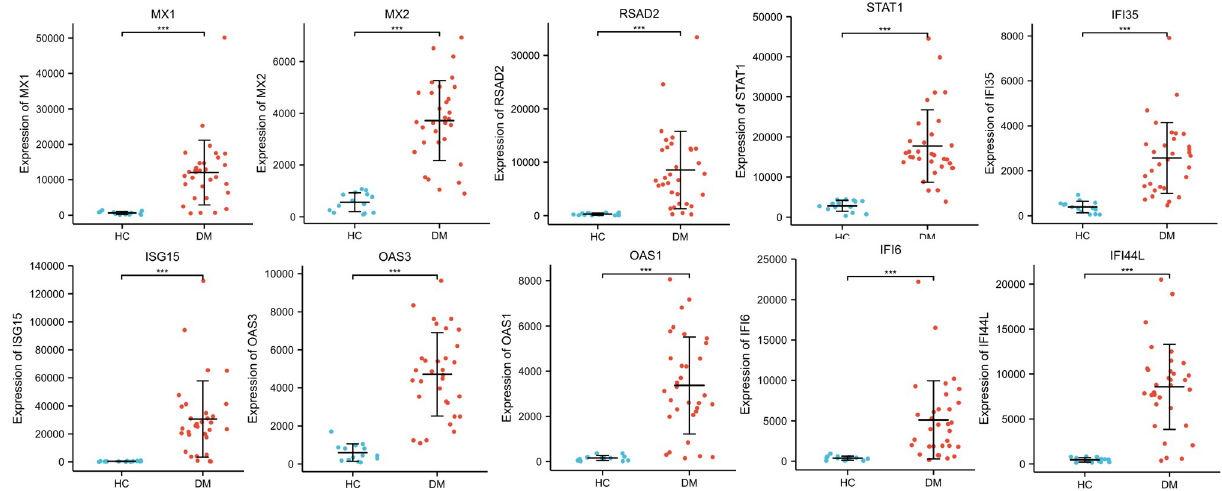
Fig 5. Verification of the 10 hub genes by GSE1551 and GSE11971 datasets. ��� : P < 0.001, all hub genes are upregulated in DM samples with significance.